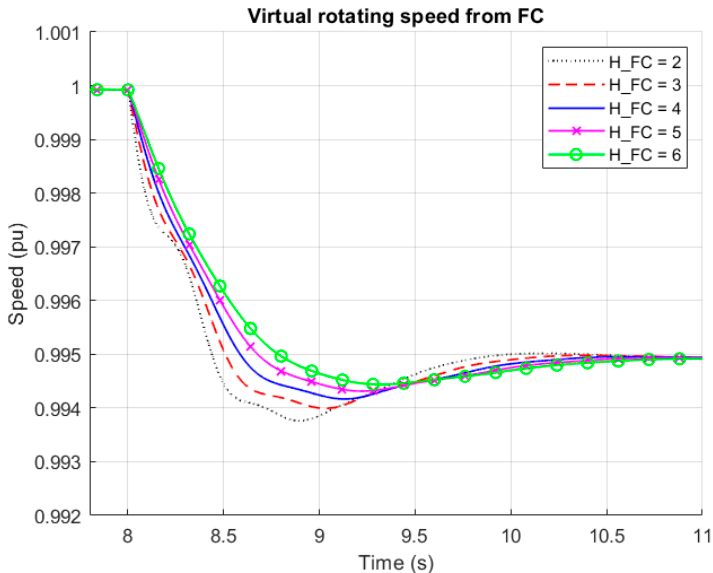
Figure 3. Influence of the inertia constant H on the virtual rotating speed of FC (H_SG = 4 W·s/VA, D r _ FC = D r _ SG = 0.05).